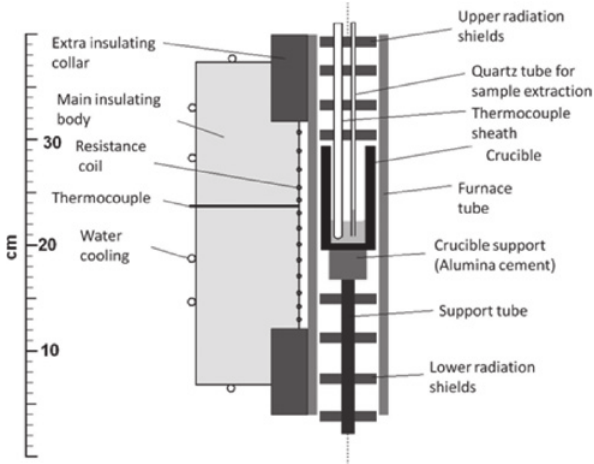
Fig. 1: Sketch of the interior of the tube furnace. The insulation and water cooling have been excluded on the right hand side of the